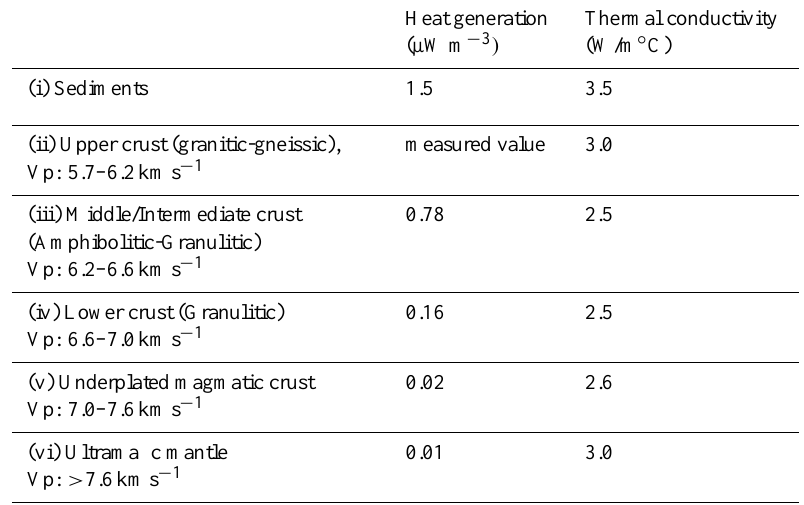
Table 2. Adapted geothermal parameters for the crust and underlying mantle lithosphere in estimating surface heat flow.